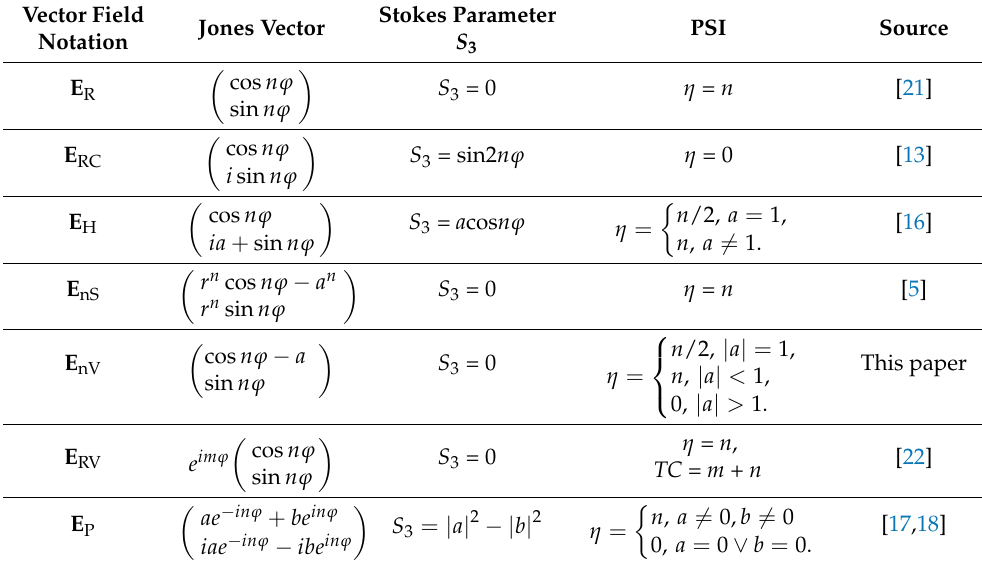
Table 1. Comparison of high-order vector fields and their PSI. Vector